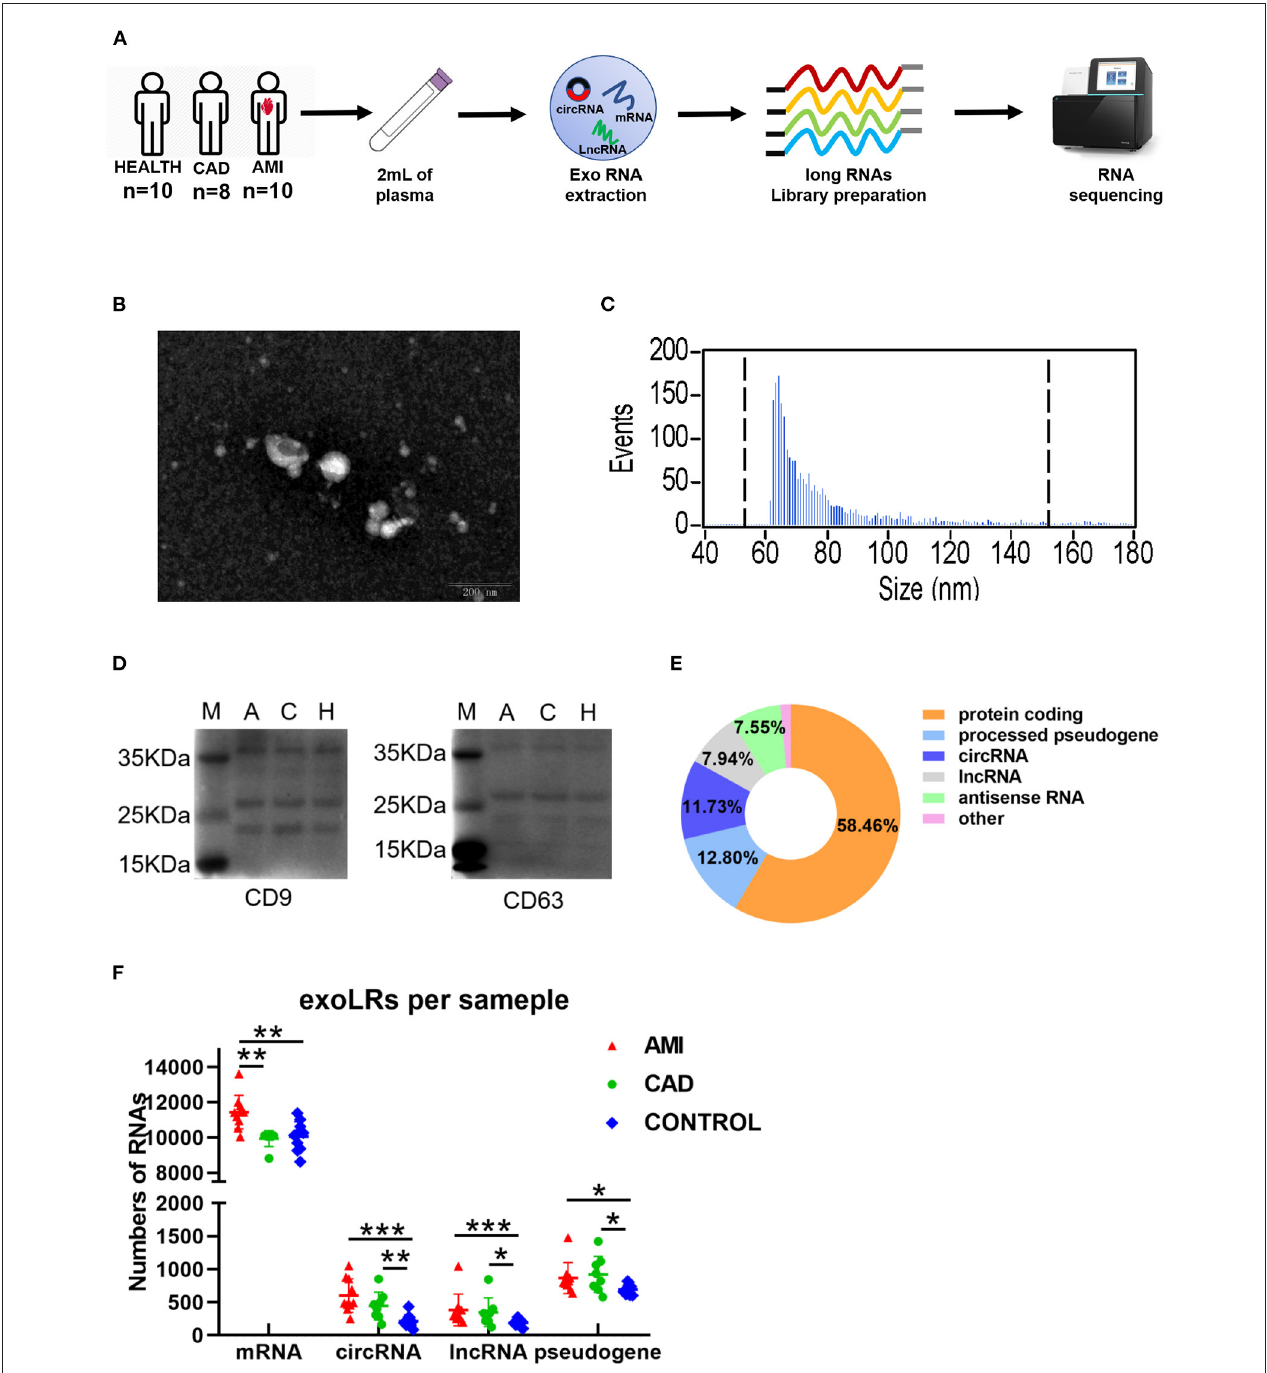
FIGURE 1 | A brief view of the workflow of human plasma exosomal long RNA-seq and its characteristics in each group. (A) Work flow of exosomal long RNA-seq of human plasma. (B) Electron microscopy image of isolated exosomes. (C) Size distribution measurements of isolated exosomes. (D) Western blot analysis of exosomal markers (M, marker; A, acute myocardial infarction; C, coronary artery disease; H, healthy individuals). (E) Distribution of mapped reads to the genes with annotation and identified circRNA. (F) The number of exoLRs for each group displayed by scatterplot. Results are described as the mean ± SD (* P < 0.05, ** P < 0.01, and *** P < 0.001; Exo RNA, exosomal RNA; exoLRs, exosomal long RNAs).